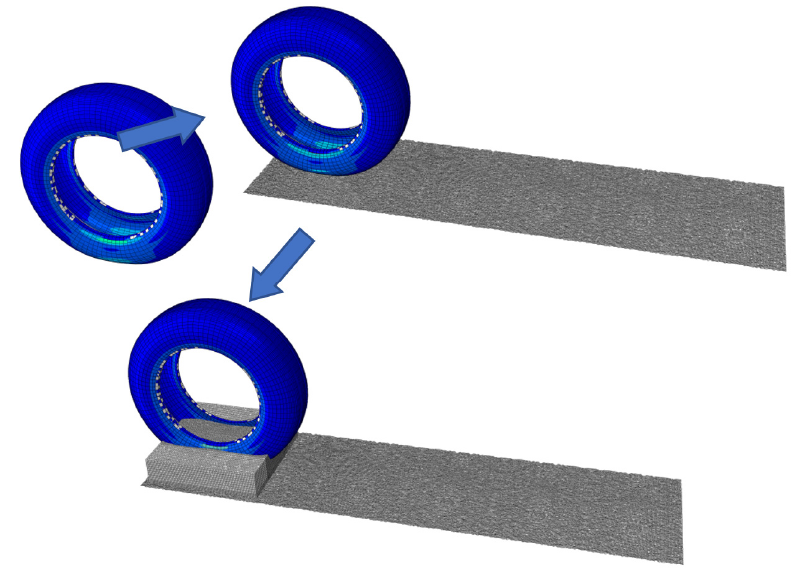
Figure 15. Modeling process of tire